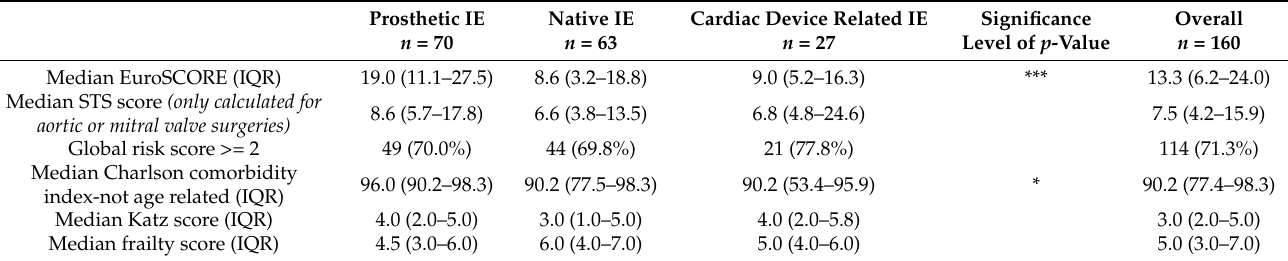
Table A4. Risk scores in CVCA registry.